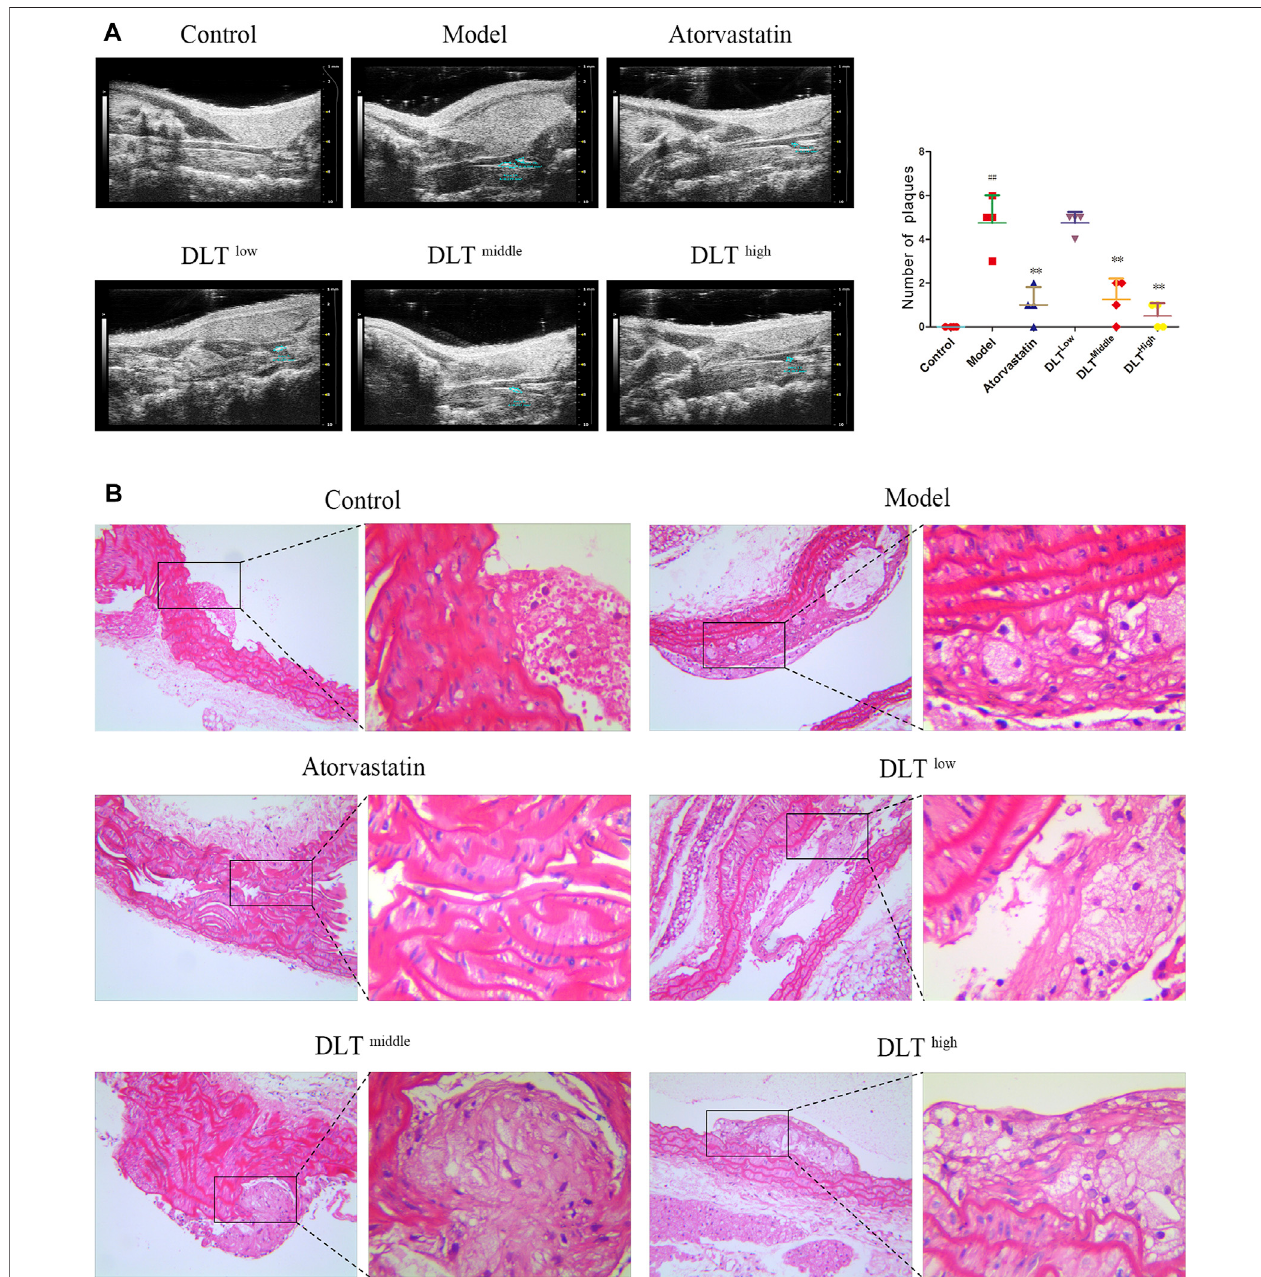
FIGURE1| DLTsreducedatheroscleroticplaqueformationoftheaortaandcarotidarteryinApoE - / - ASmice.Plaqueswereobservedby (A) vascularultrasoundof thecarotidarteryand (B) HEstainingofaortictissuesections. (A) Thecontrolgroupshowedtheuniformlycontinuousvascularacousticshadowofthecarotidartery,and no abnormal acoustic shadow was observed in the lumen; most mice in the model group had an uneven continuous sound shadow in the carotid artery, some of the vessel walls had a hyperechoic shadow, and an abnormal sound shadow was present in the vessel wall (plaques, see circled); inhomogeneous and continuous hyperechoic lights were also observed in the carotid arteries of the DLT-low group; the phenomenon was effectively restrained in DLT-middle and DLT-high groups and the atorvastatin group. The number of plaques is indicated in graphs. (B) In the model group, the endothelial layer was sloughed off, with more plaques attached to the vessel wall, intimal hyperplasia was severe, many foam cells could be observed; compared with the model group, the area of plaques in the DLT groups and the atorvastatin group was smaller, the foam cell in fi ltration was reduced and the effect was dose-dependent in the DLT groups. The high-dose DLT group and the atorvastatingroup showed continuous vascular endothelialcells. Thedataare presented asthemean ± SD( n (cid:2) 4). ## p < 0.01 vsthecontrolgroup, and ** p < 0.01 vsthe model